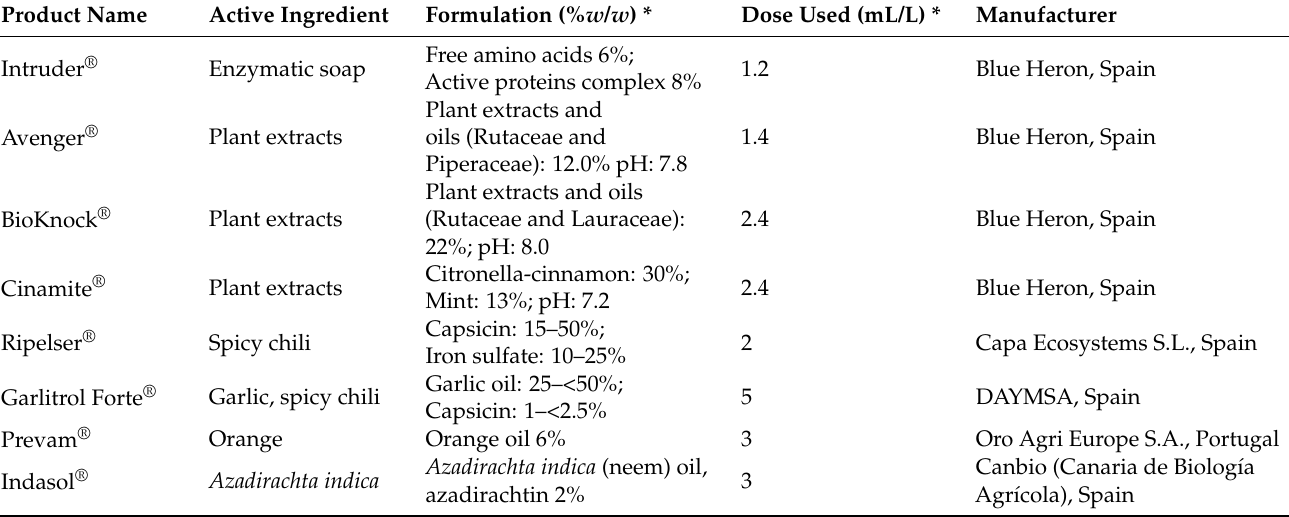
Table 1. Characteristics and description of products used in the